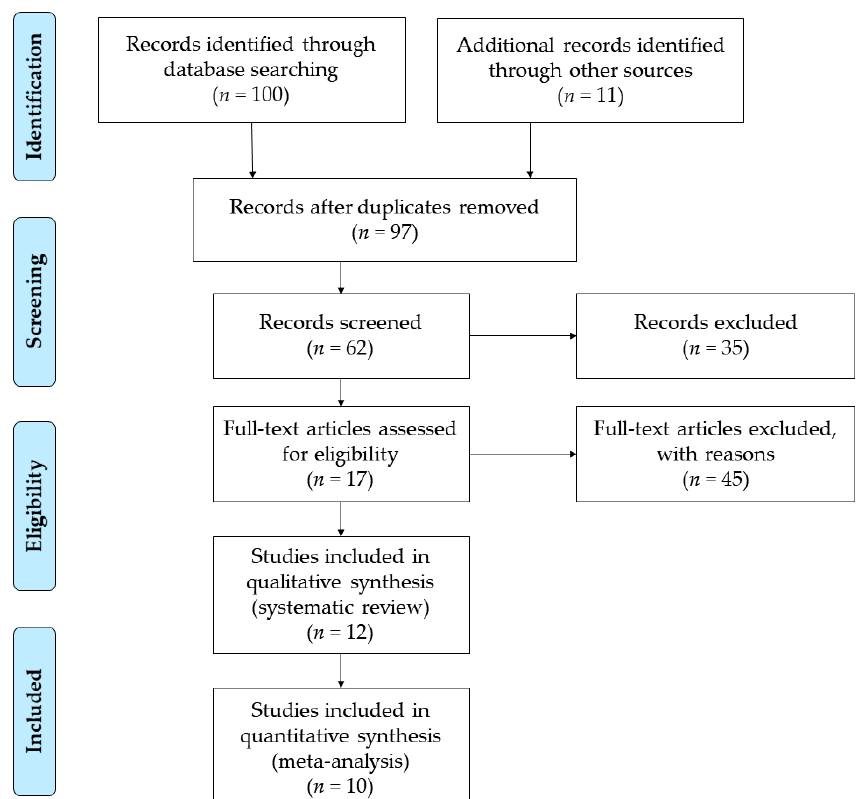
Figure 1. Flowchart according PRISMA Declaration.